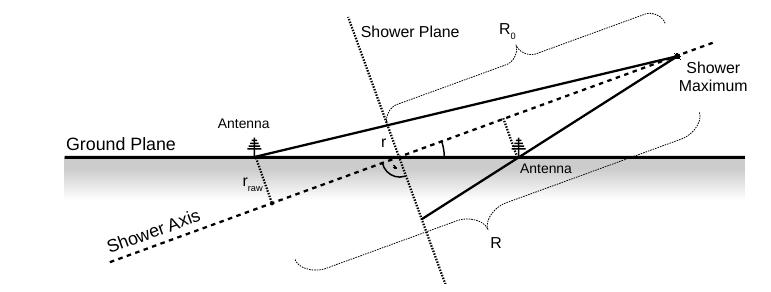
Figure 1. Illustration of the correction for early-late e ff